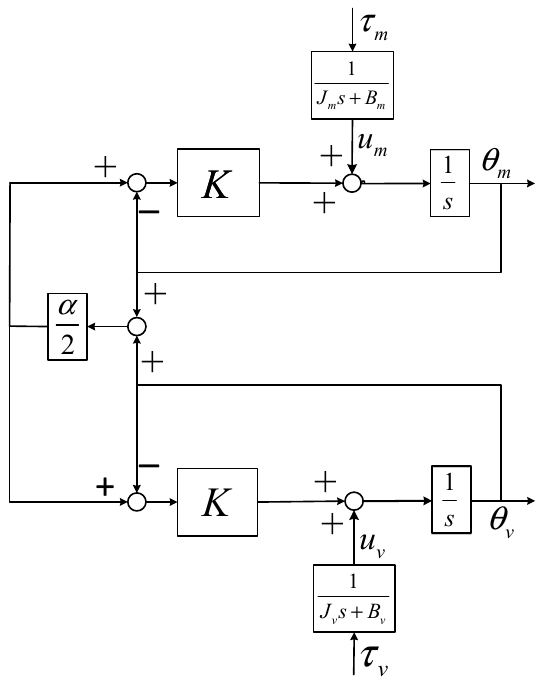
Figure 4. A simplified internal position loop of bilateral control system.